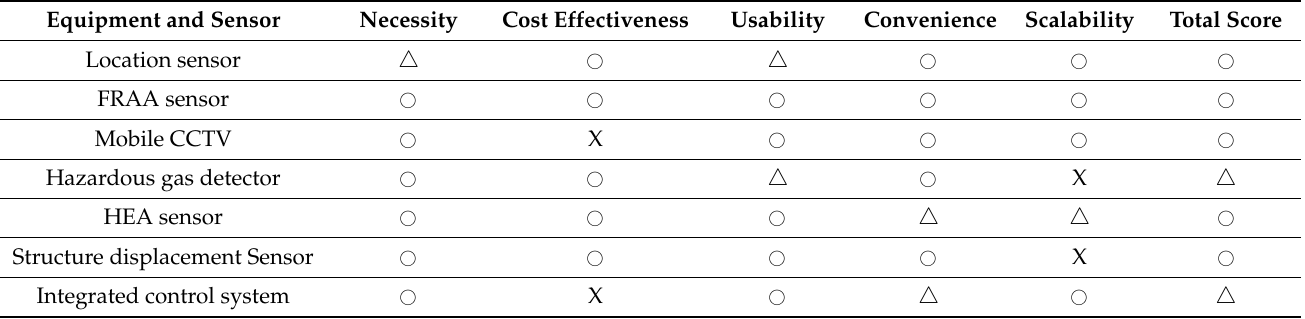
Table 6. Recommendations of